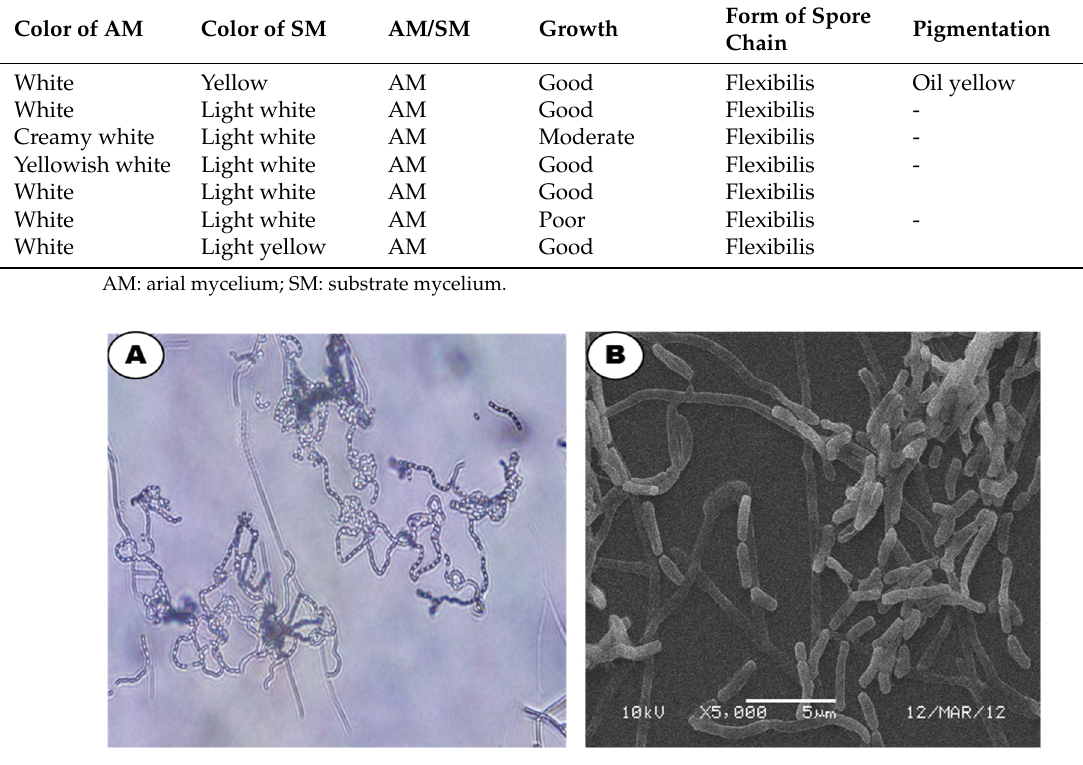
Figure 3. Microscopically examination Streptomyces sp. strain ess_amH1: ( A ) light microscopy; ( B ) SEM.